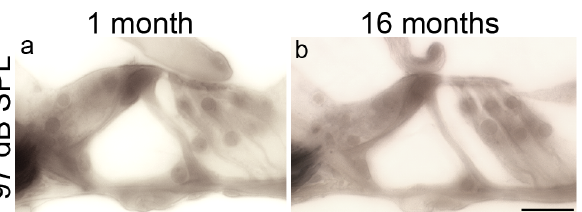
( b ) after exposure. Scale bar: 20 μ m ( a - b ).